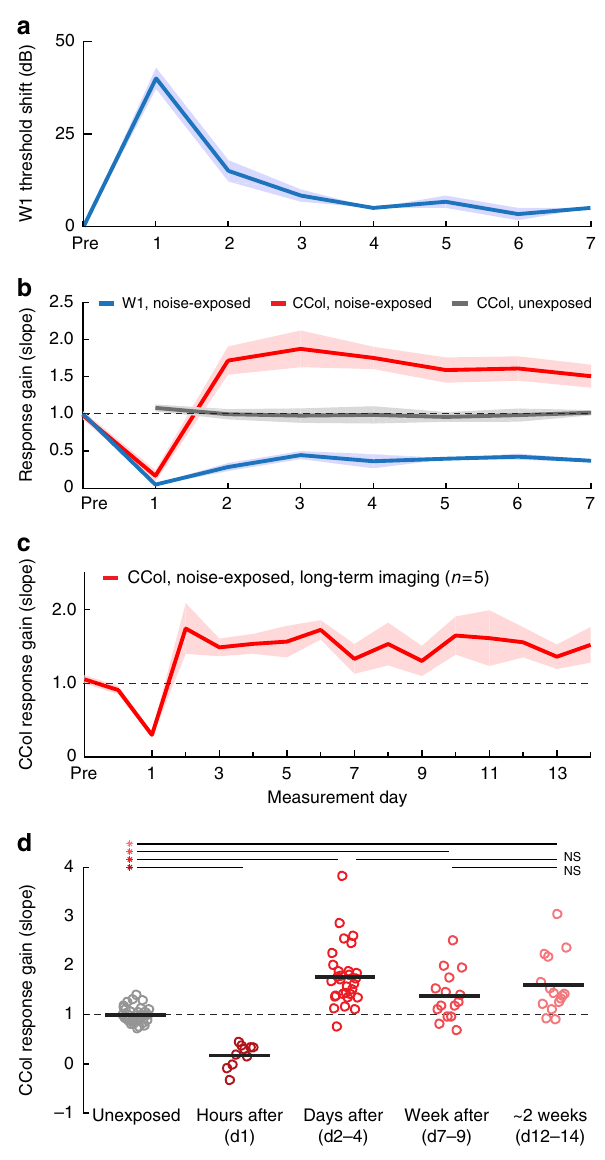
Fig. 5 ABR threshold recovery belies ongoing dynamics in auditory nerve and corticocollicular response gain. a Moderate noise exposure induces a temporary shift in the ABR wave 1 threshold to white noise bursts that resolved after 2 days. b Daily changes in response gain for CCol measurements in unexposed control (gray, n = 5) and noise-exposed (red, n = 10) mice are contrasted with daily changes in the response gain of ABR wave 1 in noise-exposed mice (blue, n = 6). In all cases, gain is calculated as the slope of the fi t line applied to sound level growth functions measured during baseline and subsequent days. c Daily changes in CCol response gain over an extended 2-week imaging period in a subset of noise-exposed mice ( n = 5). For a – c, data represent mean ± SEM. d Gain estimates from individual imaging sessions in unexposed control mice (gray) are contrasted with gain estimates measured during the fi rst imaging session following noise exposure (hours after), or during 3-day epochs occurring on D2 – D4, D7 – D9 or D12 – D14. Thick horizontal bars represent sample means. Individual circles represent all individual data points. Asterisks and NS denote statistically signi fi cant differences and lack thereof, respectively, for pairwise comparisons indicated by thin horizontal lines after correcting for multiple